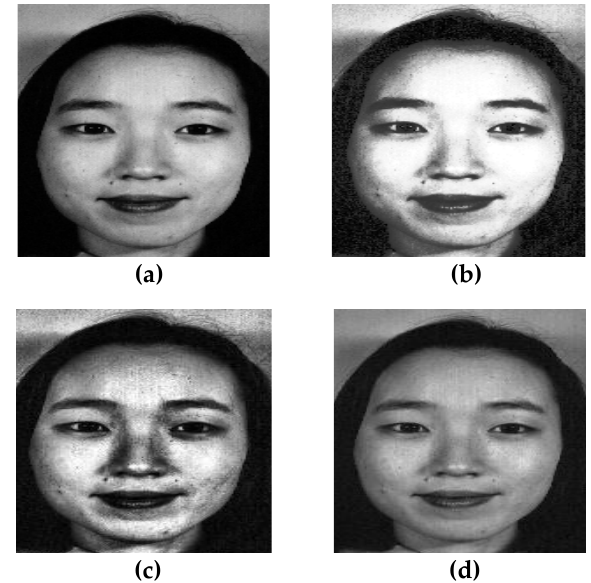
Figure 5. The results obtained from different algorithms on the JAFFE database: ( a ) original image, ( b ) histogram equalization (HE), ( c ) adaptive HE (AHE), and ( d ) contrast limited AHE (CLAHE) .